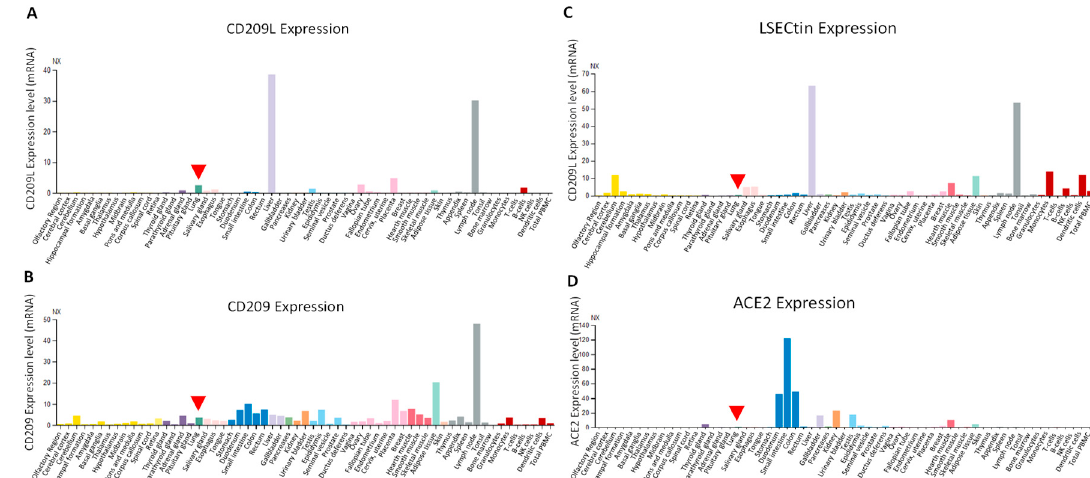
Figure 4. Expression profile of CD209L family proteins and ACE2. (A-D) Data were extracted from the Human Expression Atlas (data was accessed in 11/03/2020) [101]. Arrowhead points to expression of individual genes in lung.